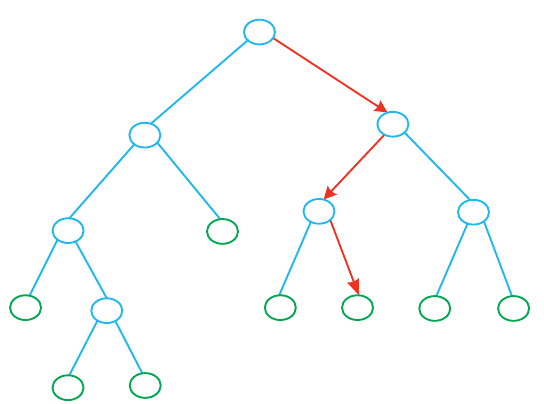
Figure 6: Decision tree.